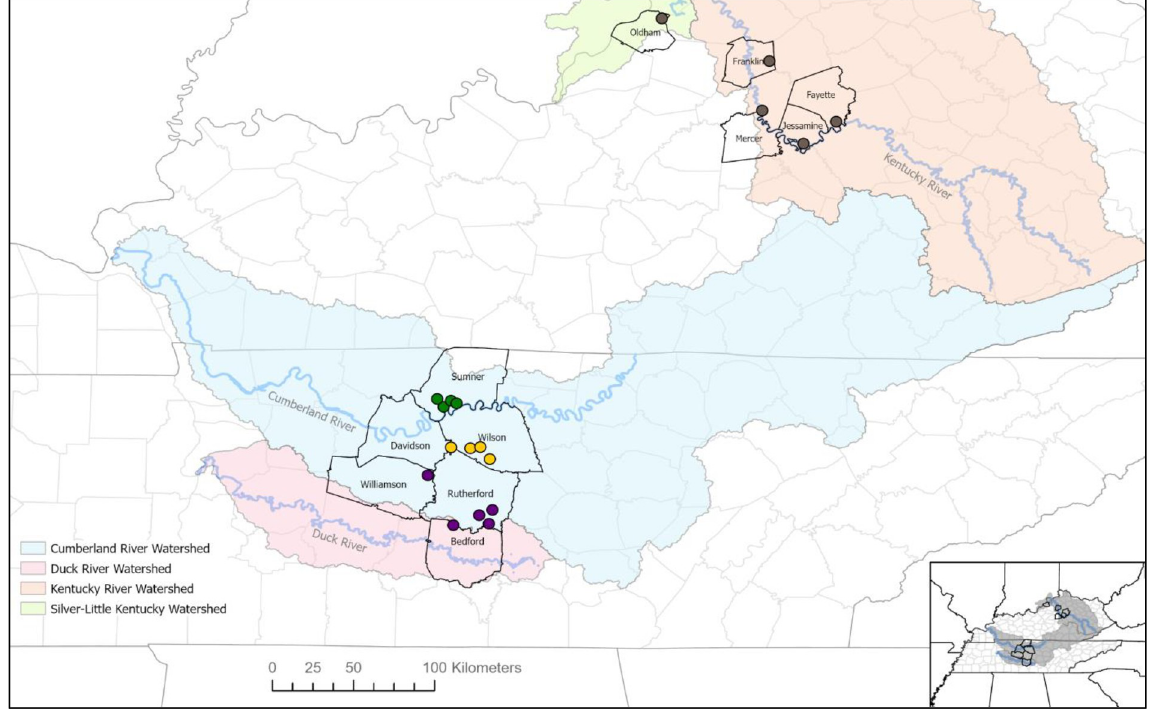
Fig 2. Map of surveyed populations of A . barbouri in Tennessee and Kentucky. County lines are shown with black borders. Shaded regions indicate major watersheds as depicted in the legend. Tennessee populations are colored by ESU assignment where green circles indicate northern ESU populations, yellow circles indicate central ESU populations, and purple circles indicate southern ESU populations.